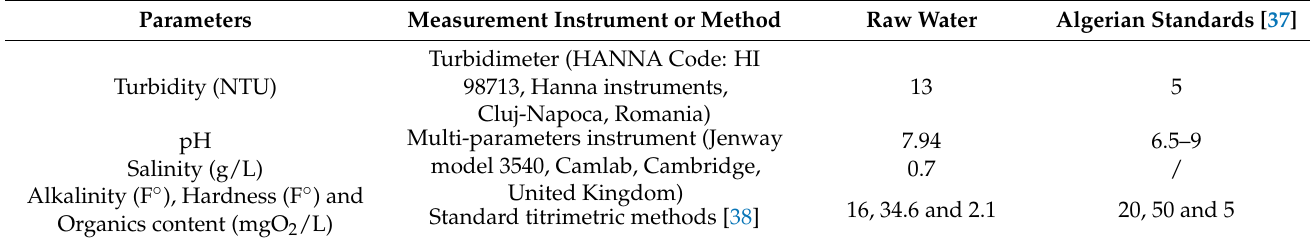
Table 1. Raw water characteristics; measurement instruments, and methods; Algerian water quality